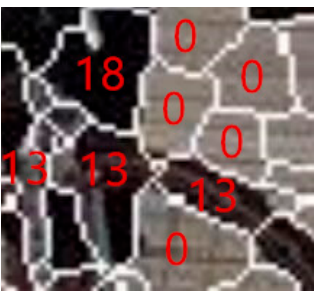
Figure 4. Superpixel semantic annotation information. The area consisting of white lines is produced by superpixel segmentation, while the red numbers represent the semantic labels of each region.